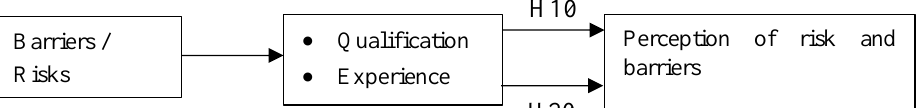
Figure 1. Research methodology